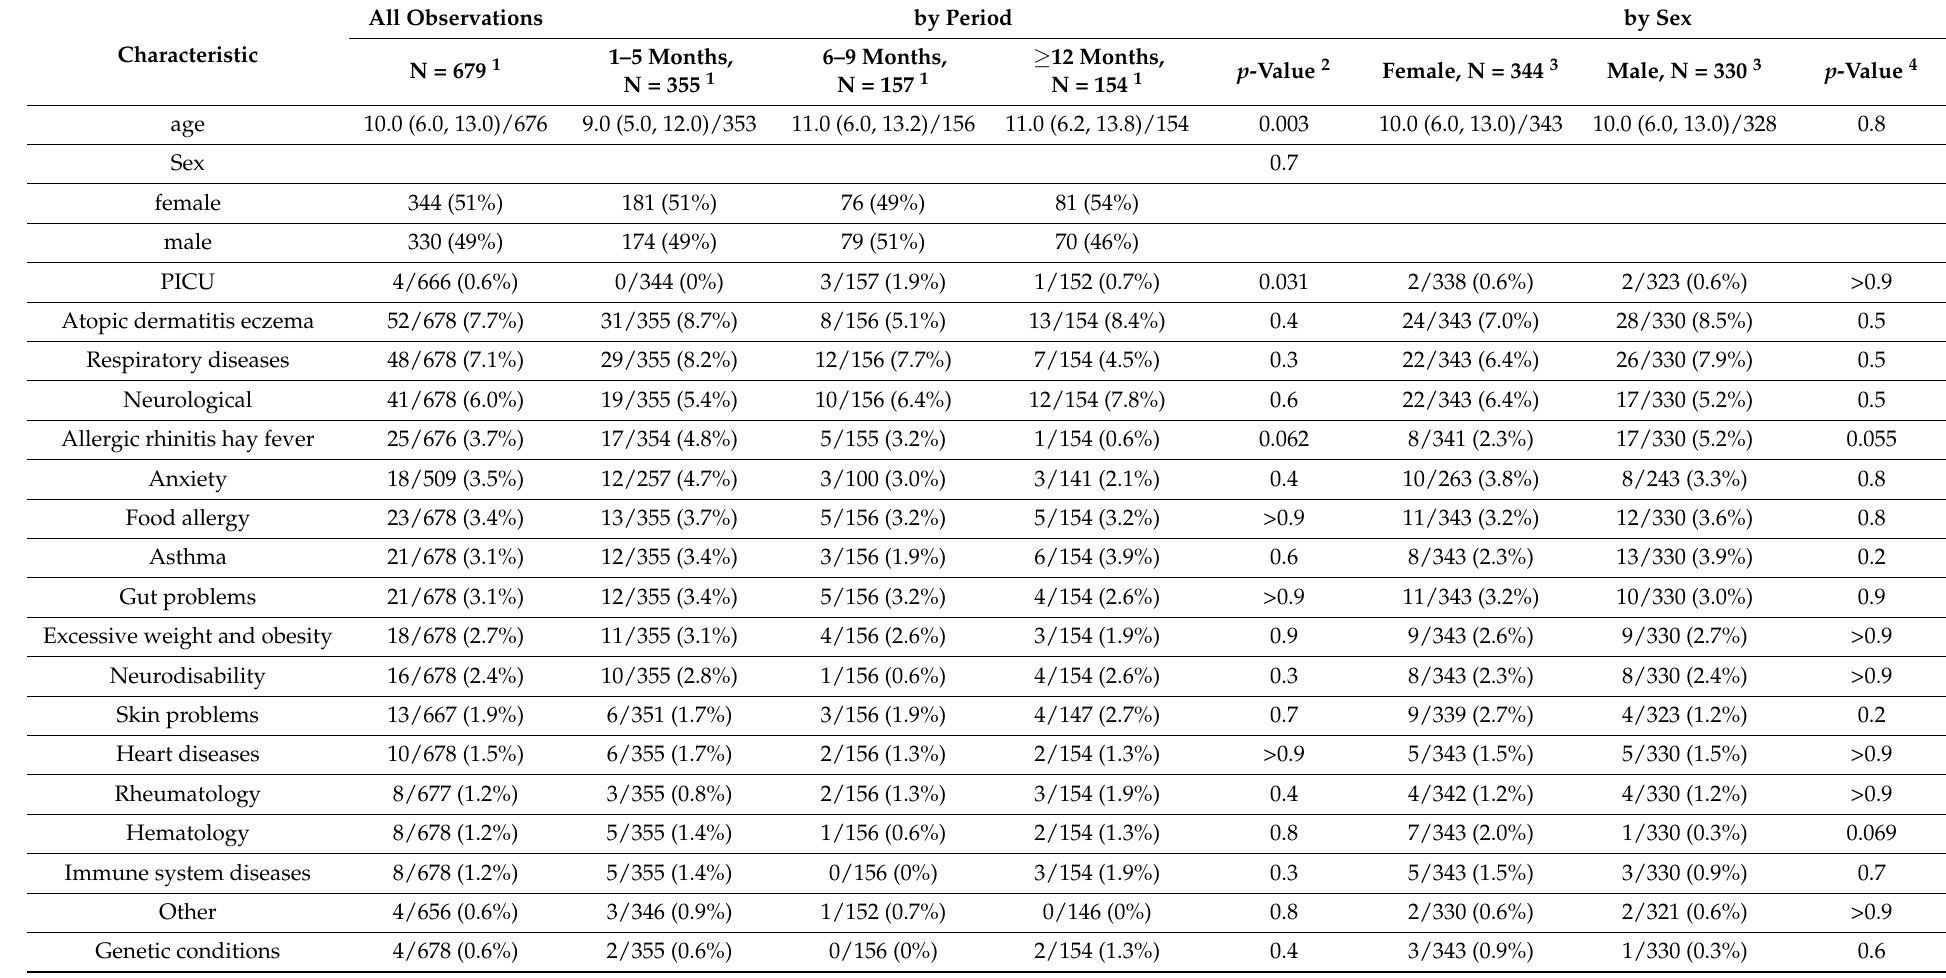
Table 1. Distribution of the cohort by period, by sex and by